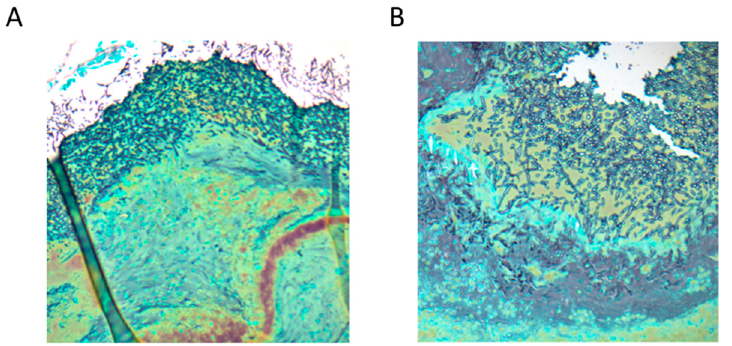
Figure 3. Images from Gomori methenamine silver staining (GMS) of samples obtained by the aspiration of nasal secretions technique. ( A ) Massive presence of fungal hyphae (50× magnification); ( B ) Massive presence of fungal hyphae (100× magnification).